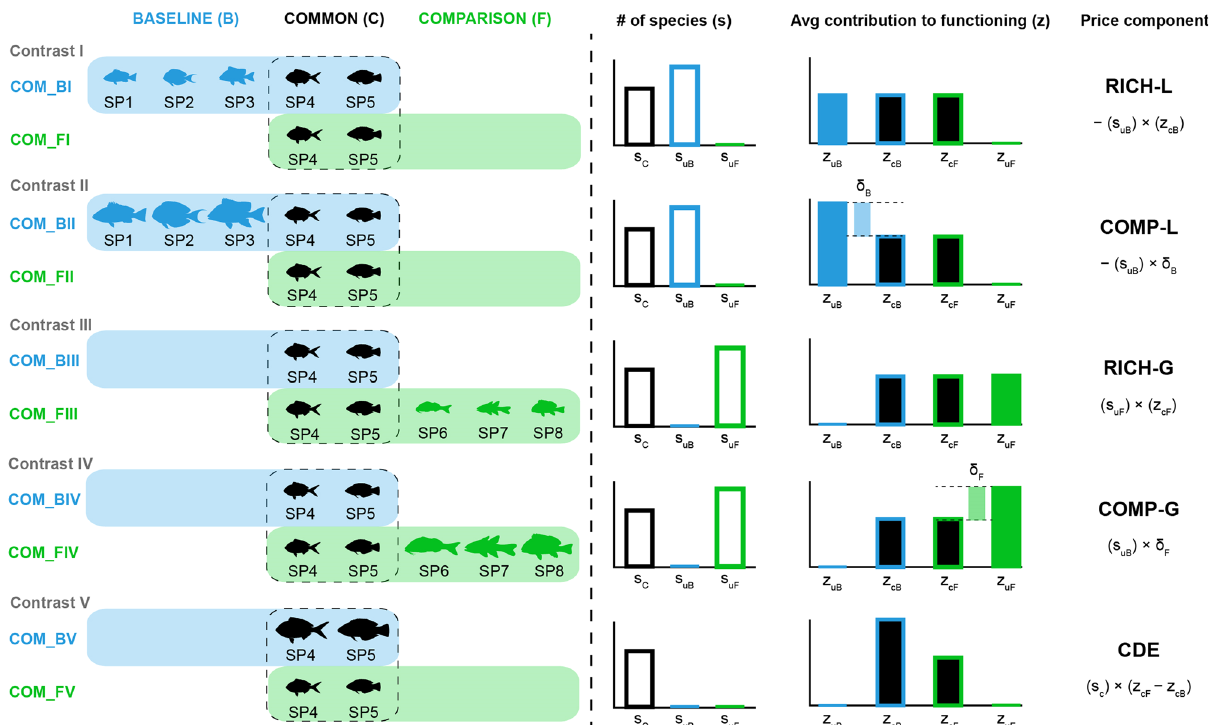
Fig. 1 A conceptual representation of our decomposition quantifying the difference in biomass between two sites: a reference or reference site ( B ) and a comparison site ( F ). Notation: S c , S uB , and S uF refers to the number of species: in common, unique to B and unique to F , respectively; and Z uB , Z cB , Z cF , and Z uF to average ecological function (in this example, biomass) of species: unique to B , common to both sites when present at B , common to both sites when present at F , and unique to F , respectively. The fi rst term, RICH-L , re fl ects loss of species from the reference site that are most like the average of the species that are retained. In Contrast I, the comparison site lacks some species present at the reference site (left column), so the species richness is lower at the comparison site (second column). In this case, the species in common between the two sites have the same average contribution to biomass (per species) as species unique to the reference (i.e., z cB = z uB , third column). Thus, the difference in biomass between the two sites in Contrast I is entirely captured by the RICH-L effect (last column). The second term, COMP-L , re fl ects the loss of biomass beyond what is expected given the number of species lost and average per species contribution of the reference species, i.e., the shared species. Unlike in Contrast I, in the case shown for Contrast II the species unique to the reference site are larger and therefore greater contributors (per species) to total biomass than the species that are shared between sites ( (cid:1) z uB (cid:1) (cid:1) z cB = δ B > 0). The difference in total biomass between communities in Contrast II would be captured by the COMP-L term (last column) in addition to the RICH-L term (as shown for Contrast I). The RICH-G and COMP - G terms are analogous to RICH-L and COMP - L but arise from species that are present in the comparison site and absent from the reference (as illustrated in Contrasts III and IV). The fi nal term, the “ context-dependent effect ” or CDE , considers only the species shared among both the reference and comparison sites. Differences in the contributions of shared species among the two sites re fl ect processes other than changes in richness and composition, such as changes in per species biomass, community size structure, resources, or the abiotic environment (e.g., temperature). In Contrasts I-IV, the shared species did not differ in their average per species contribution between the two sites (i.e., z uF = z cB ) so there was no CDE . In Contrast V, the shared species differ in their average per species contribution to biomass, resulting in a nonzero CDE . In a real comparison, all fi ve components can occur simultaneously. The fi ve components sum to the observed difference in biomass between the reference and comparison